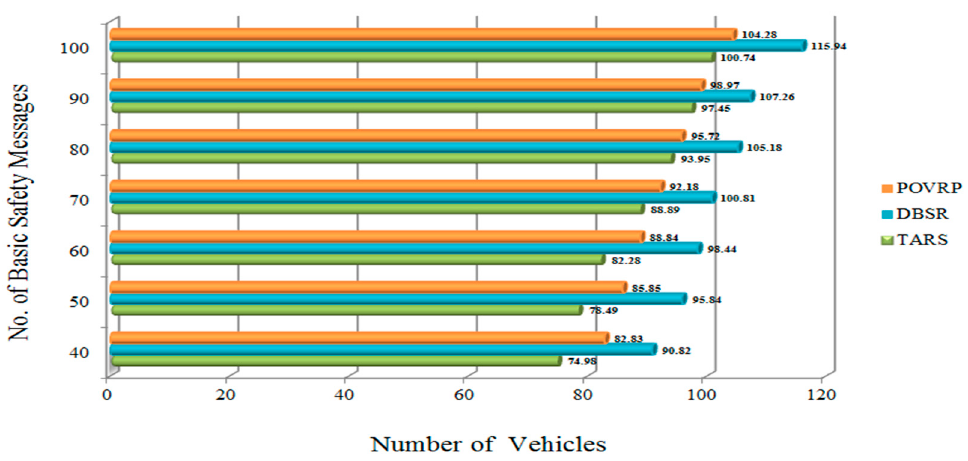
Figure 11. Basic Safety Message in the highway scenario.